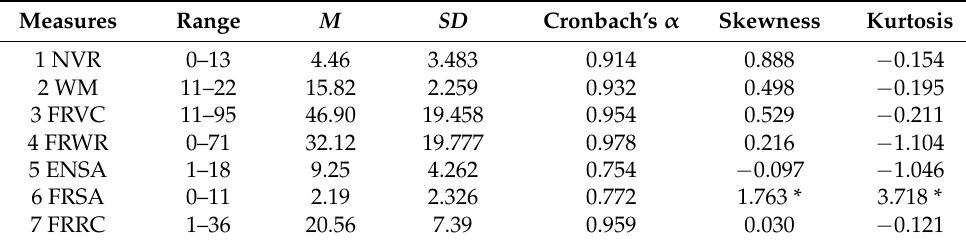
Table 1. Descriptive statistics of all measures ( n =